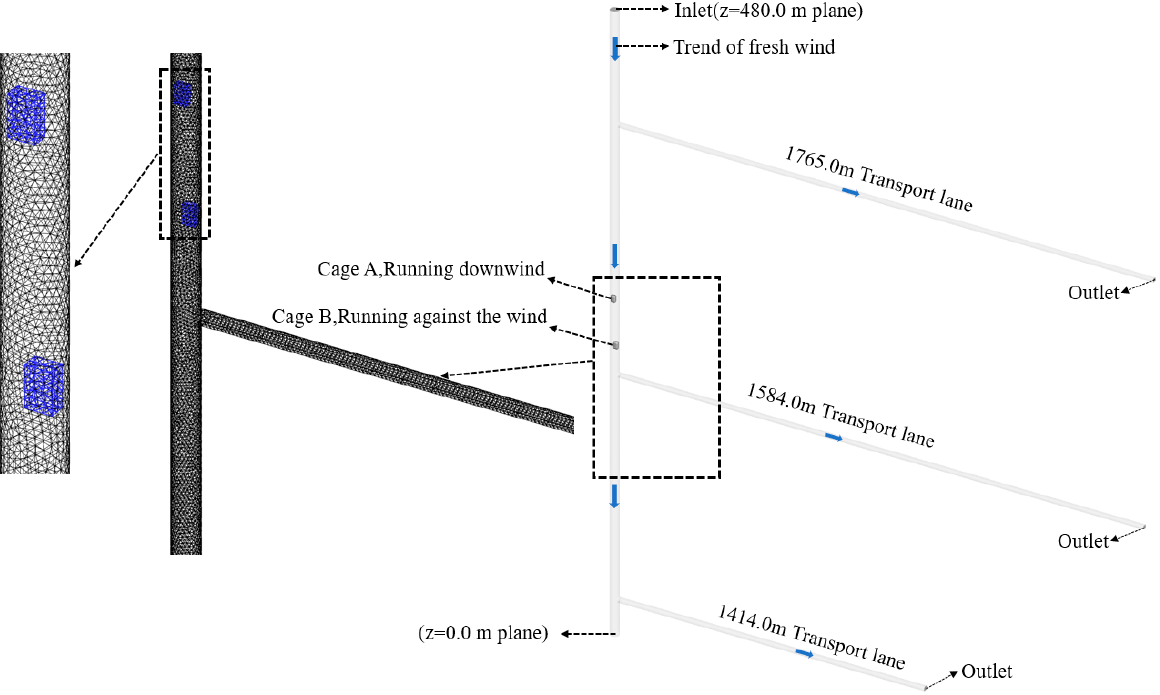
Figure 2. 3D geometric model and meshing diagram of double cage hoisting in the shaft.